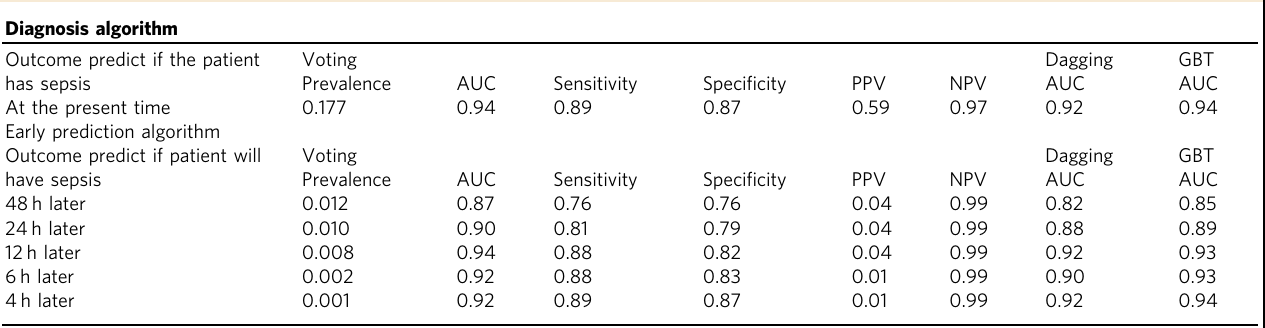
Table 3 Statistics of diagnosis and early prediction algorithm (in low prevalence condition without SMOTE). Diagnosis